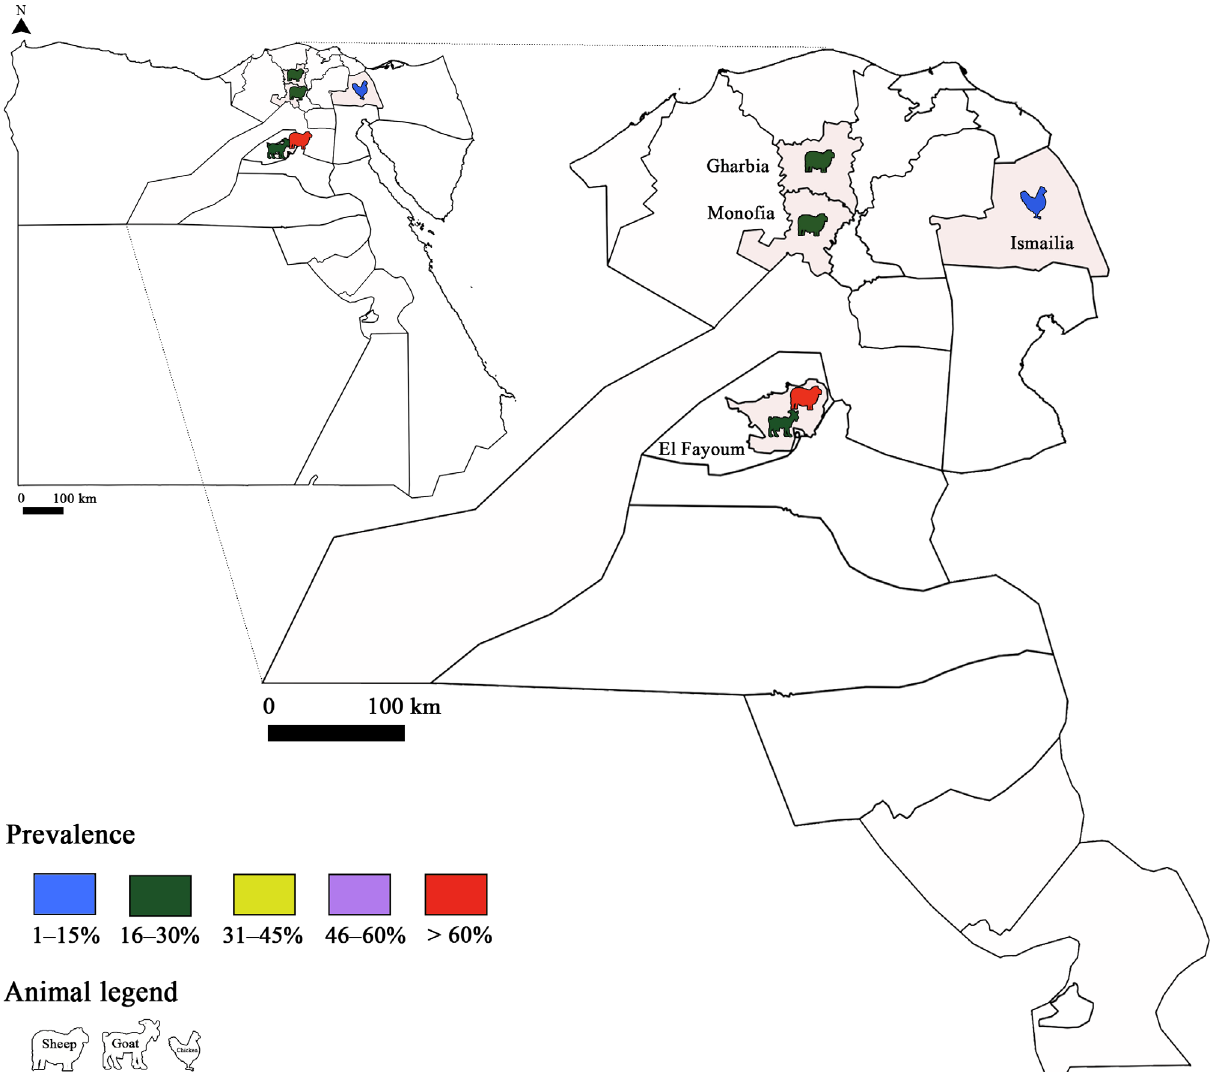
Figure 7. Prevalence of Toxoplasma gondii infection in Egypt: Animal toxoplasmosis, molecular